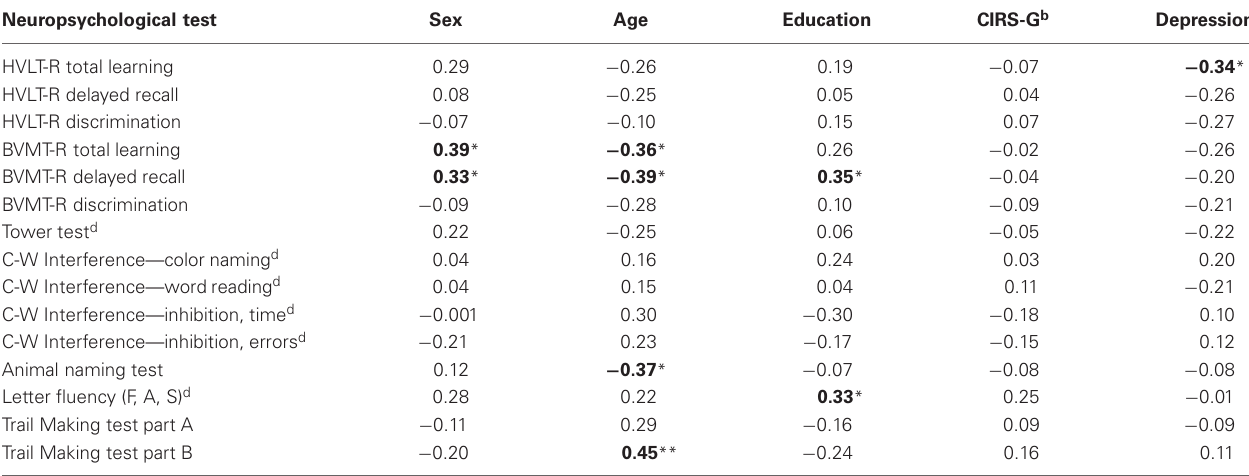
Table 3 | Pearson correlations between demographical variables and the patients’ neuropsychological raw scores a . Neuropsychological test